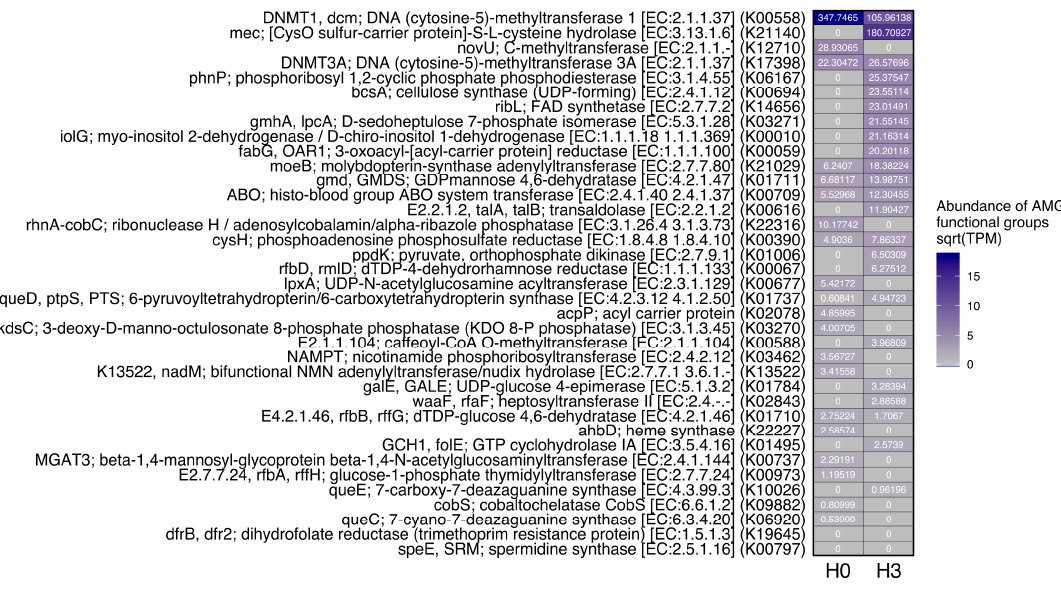
Figure 5. Viral auxiliary metabolic genes (AMGs) heatmap generated with VIBRANT.